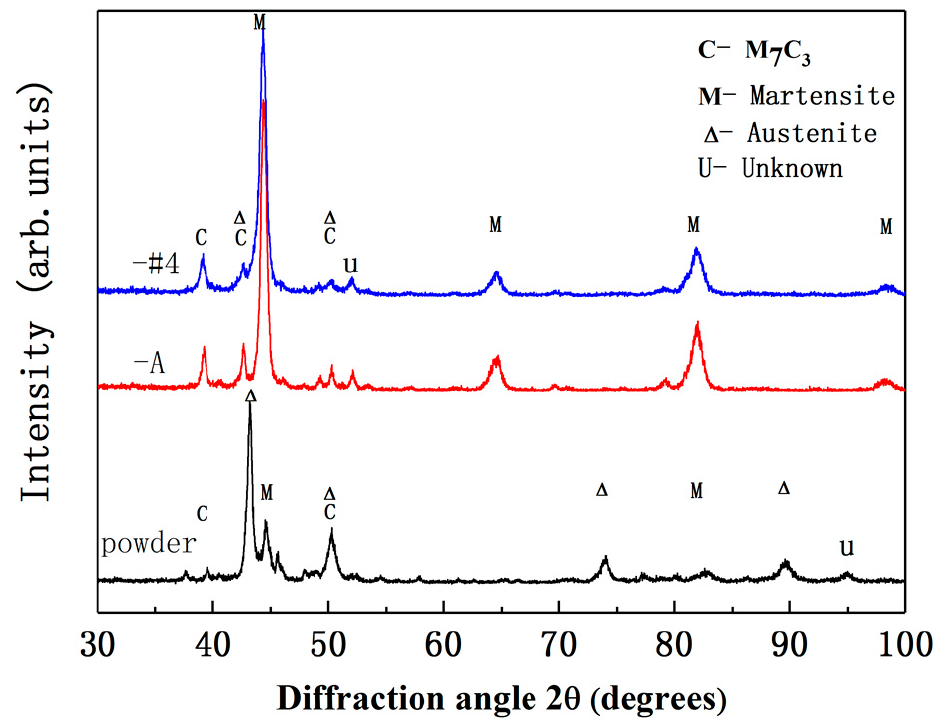
Figure 7. X-ray diffraction curves of a HCCI (powder, specimen A, and specimen #4).